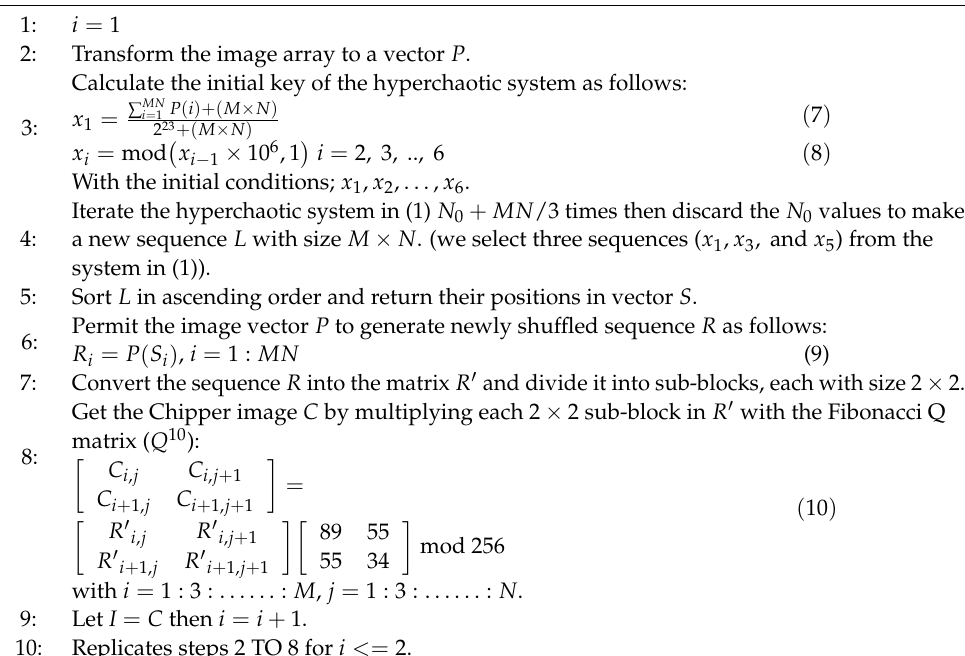
Algorithm 1 The image encryption